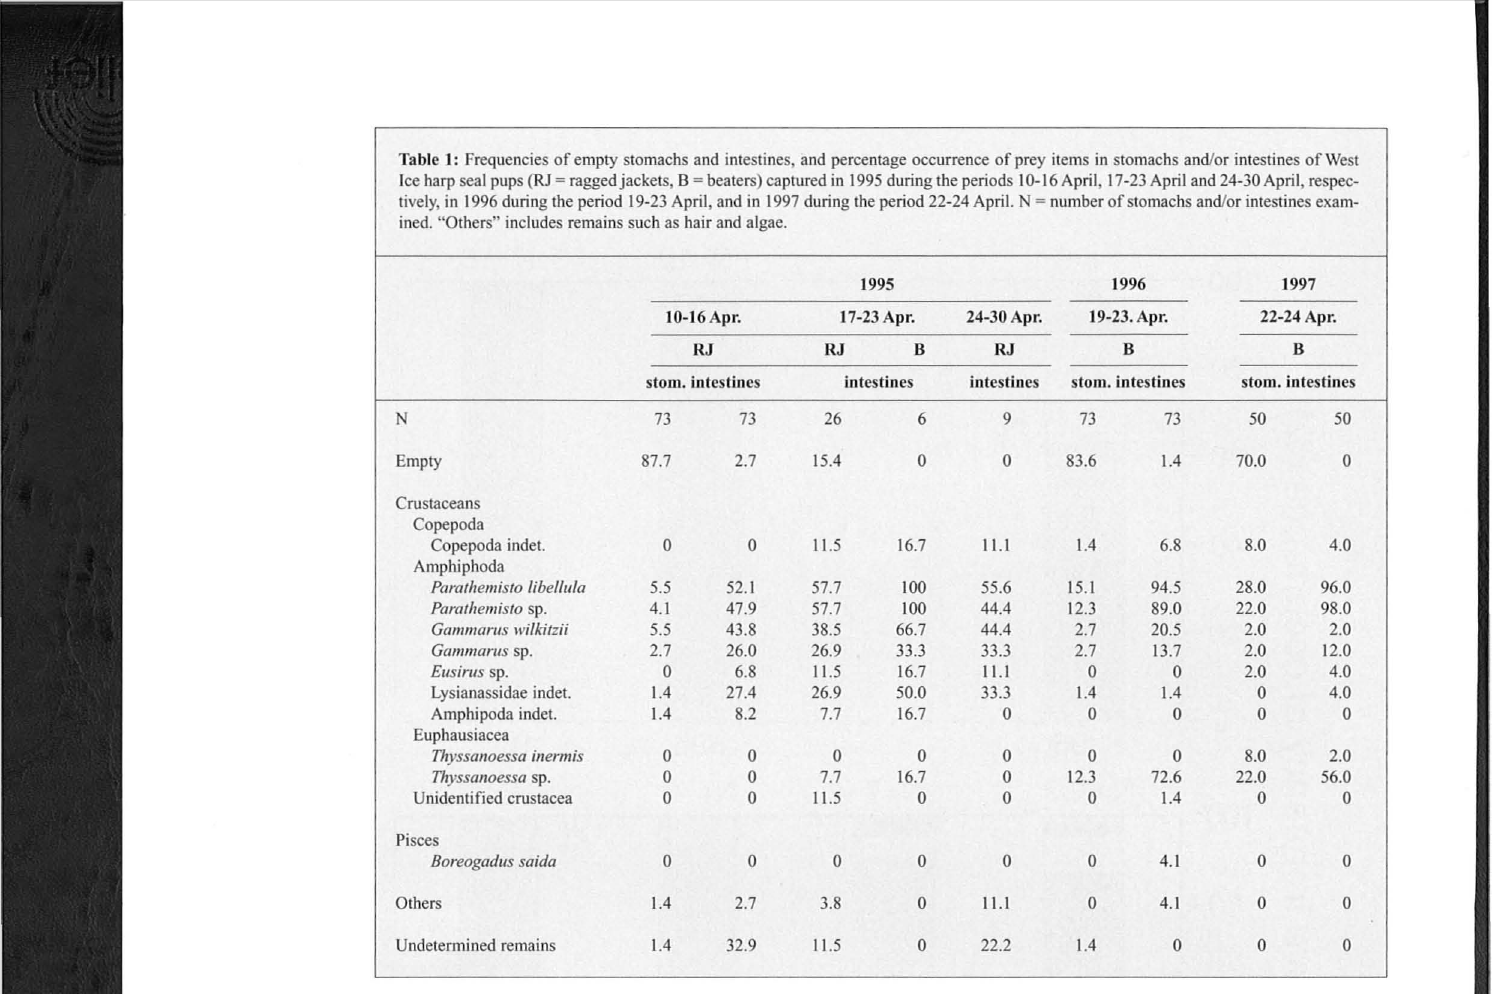
Table I: Frequencies of empty stomachs and intestines, and percentage occurrence of prey items in stomachs and/or intestines of West Ice harp seal pups (RJ = ragged jackets, B = beaters) captured in 1995 during the periods 10-16 April, 17-23 April and 24-30 April, respec- tively, in 1996 during the period 19-23 April, and in 1997 during the period 22-24 April. = number of stomachs and/or intestines exam- ined. "Others" includes remains such as hair and algae.